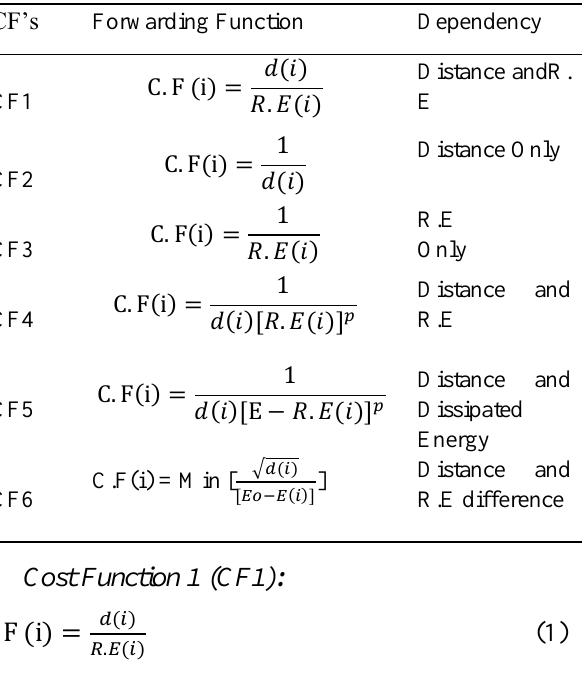
Table 2 Cumulative Cost Functions.